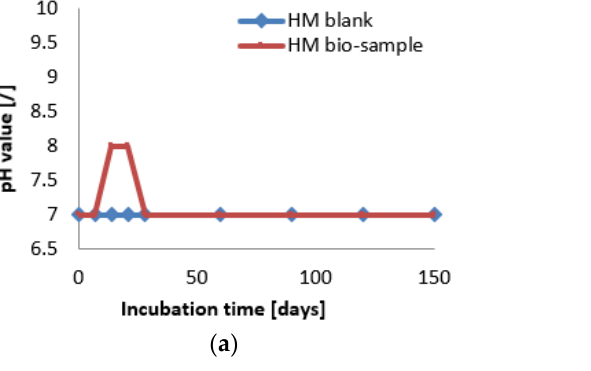
Figure 7. The pH monitoring of HM samples ( a ) and MM samples ( b ) [6].